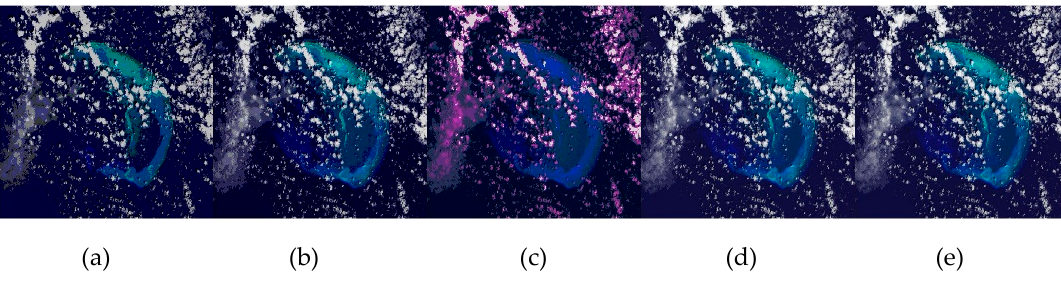
Figure 15. The segmented result of Satellite image8. ( a ) WOA; ( b ) FPA; ( c ) PSO; ( d ) BA; and ( e ) HSOA.